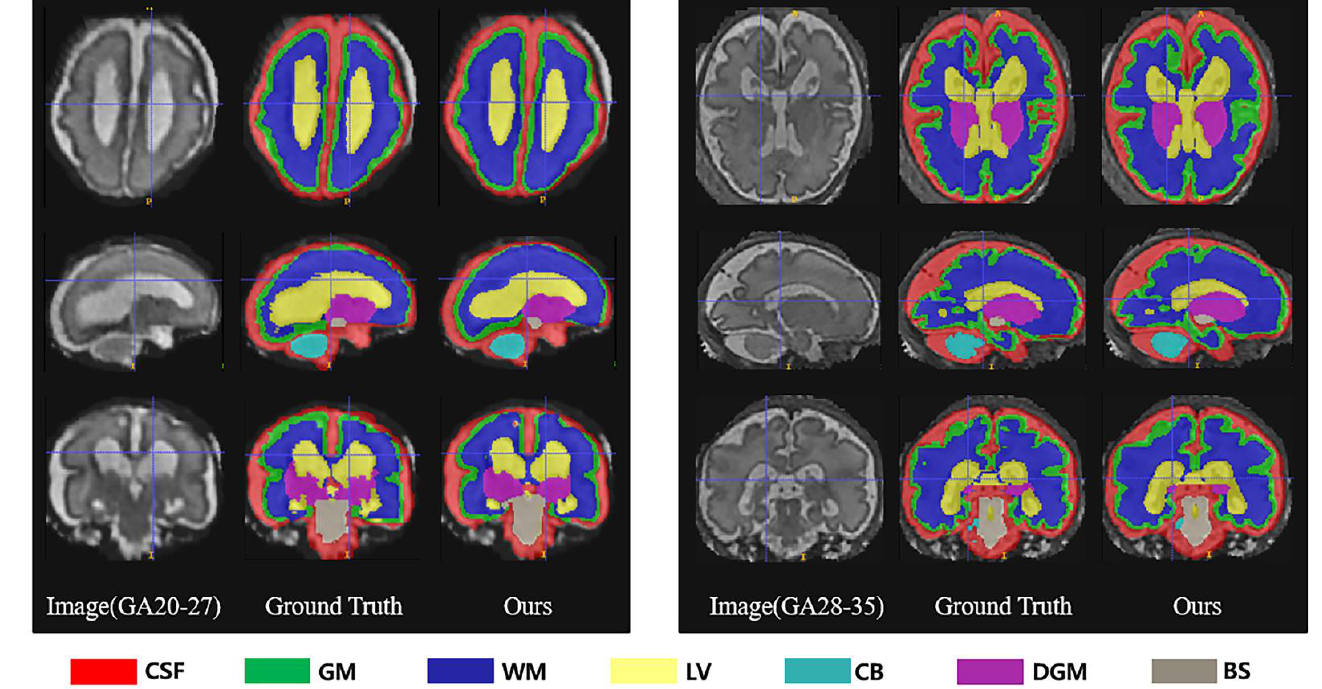
Figure 7. Segmentation results of different gestational age groups (20 – 27 weeks and 28 – 35 weeks) in axial, sagittal and coronal planes respectively.